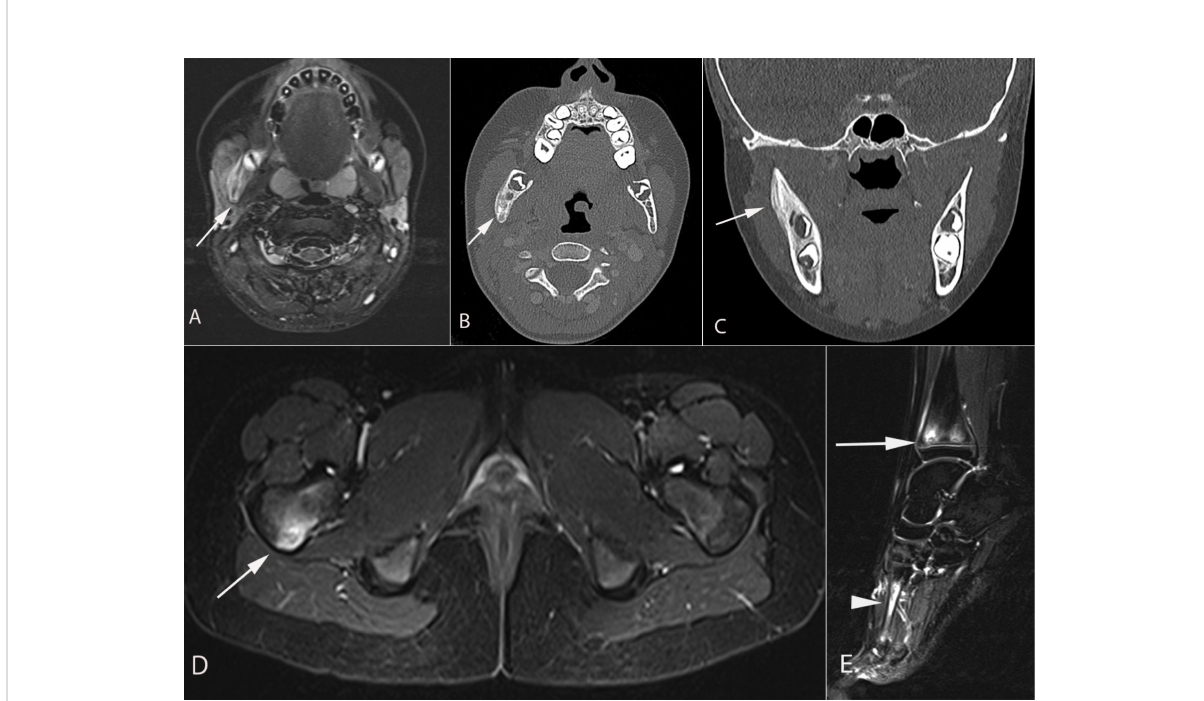
FIGURE 1 A 9-year-old girl presented with 10 days of right cheek swelling. (A) MRI Axial T2 STIR demonstrated asymmetric enlargement of the right masseter muscle with a heterogeneous hyperintense signal of the right mandibular ramus (arrow) in keeping with bone marrow edema. (B) axial computed tomography and (C) coronal computed tomography images demonstrate smooth periosteal reaction in the right hemi mandible. No associated soft tissue mass or periodontal abscess. Axial (D) and sagittal (E) MRI STIR images demonstrate another focus of hyperintensity in the posterior aspect of the right femoral neck (arrow in D ), the distal tibial metaphyses (arrow in e), and the right fi rst (arrowhead in e) and second metatarsals (not shown). Findings are consistent with CRMO following a Whole Body